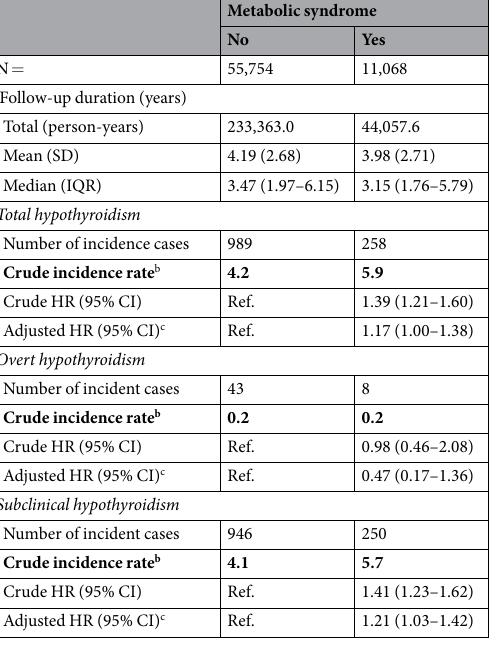
Table 2. Follow-up duration, number of incident cases, crude incidence rate, and hazard ratios of hypothyroidism between participants with and without metabolic syndrome at the baseline (N = 66,822 a ). a Excluding participants with prevalent hypothyroidism at the baseline (N = 1,151), those with missing information or measurement error of thyroid function test (N = 631), and those who had ever received undetermined thyroid medicine during the follow-up period (N = 139). b Crude incidence rate: per 1,000 person-years. c Multivariable Cox proportional hazards analyses were adjusted for sex, age group, low educational level, physical inactivity, cigarette smoking, and alcohol